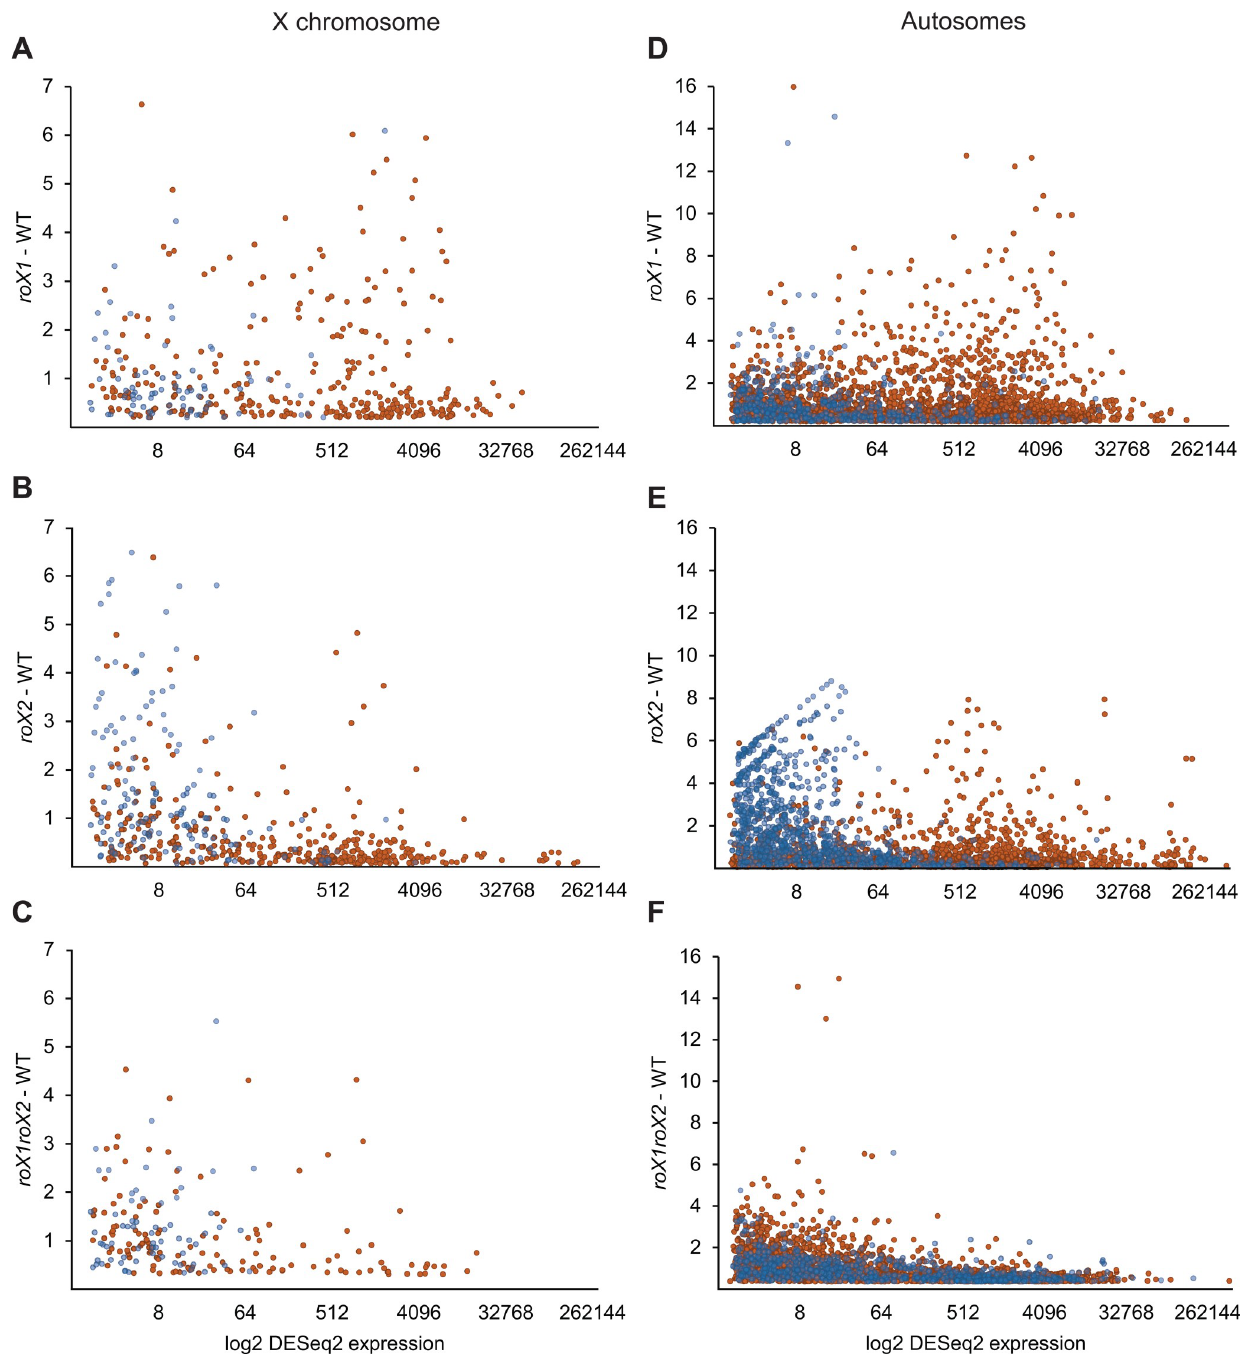
Fig 7. Testis-biased genes are upregulated in the roX2 mutant. Expression ratios plotted against log2-converted expression value for testis-biased genes (blue) and all other genes (orange). (A-C) show X chromosomal genes; (A) roX1 –WT, (B) roX2 –WT, (C) roX1 roX2 —WT. (D-E) show autosomal genes; (D) roX1 –WT, (E) roX2 –WT, (F) roX1 roX2 —WT. Testis-biased genes were determined as genes with testis enrichment scores exceeding 4 according to the FlyAtlas2 expression